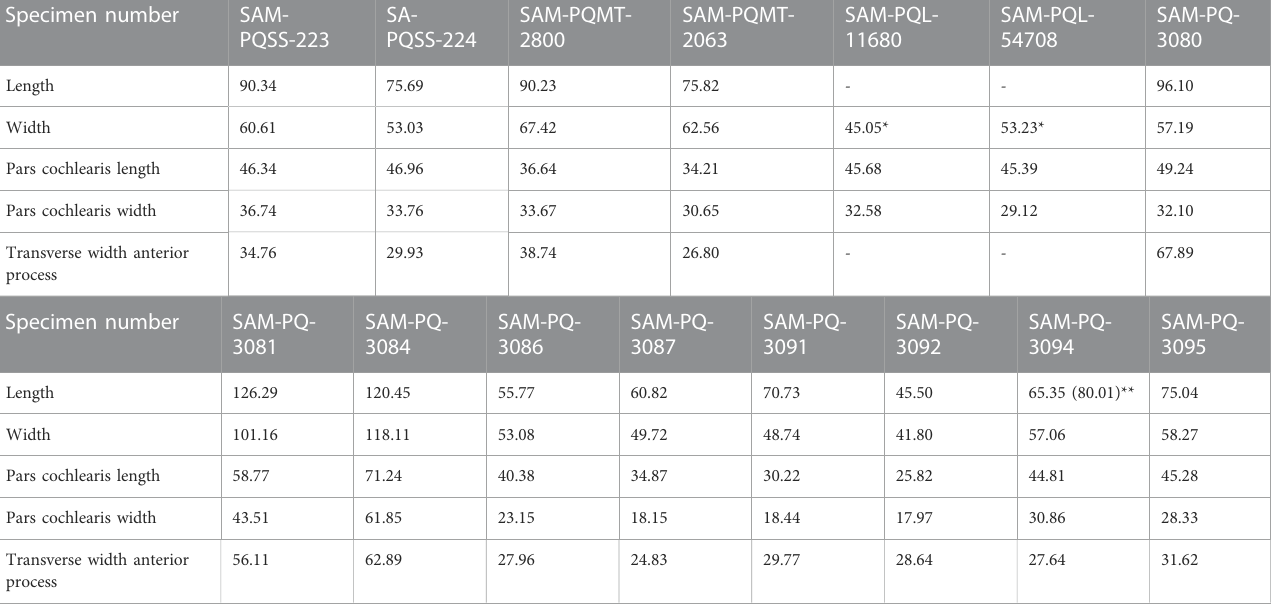
TABLE 2 Measurements (in mm) of isolated periotics from Saldanha Steel, Langebaanweg, Milnerton, and offshore trawls. Specimen number